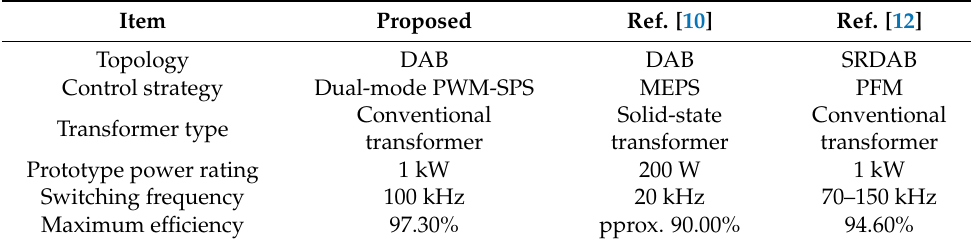
Table 1. Comparison of the DAB converter with different control strategies.